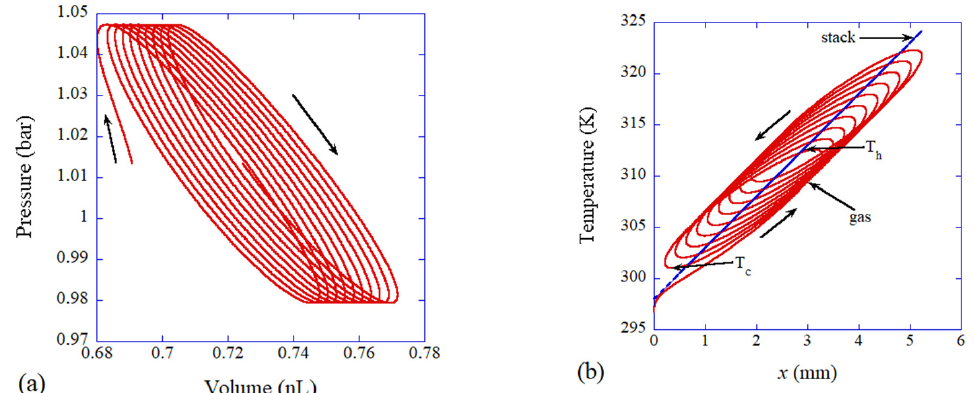
Figure 15. The results of the numerical simulation of the ODE model for a gas parcel in a traveling- wave thermoacoustic engine near the cold end of a dry stack ( a ) p-V diagram. ( b ) T-x diagram. Reprinted with permission from Ref. [91]. Copyright 2021, AIP Publishing.